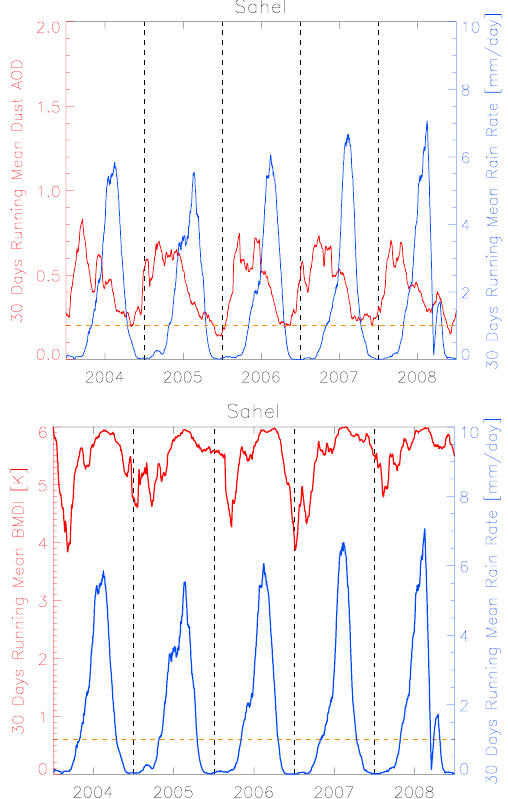
Fig. 2. Sahel daily rain rates (30 day running mean, blue) and min- eral dust AOD from MODIS (top) and BMDI (bottom) (30 days running mean, red) time series for the years 2004–2008. The hori- zontal dashed lines are the 1mm/day rain rate threshold to separate monsoon and dry seasons.